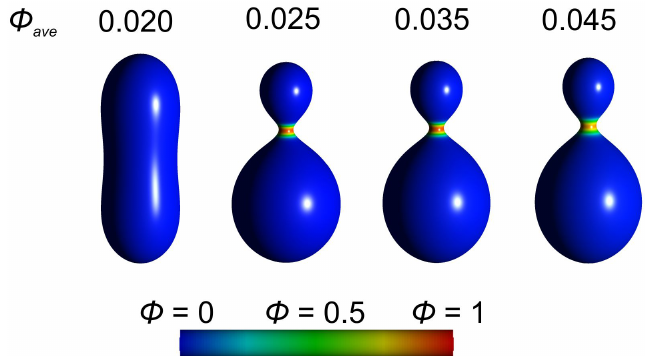
Figure 21. Equilibrium closed membrane shapes calculated for different values of the average relative area density φ ave of anisotropic saddle-like nanodomains A . Membrane contains two types of nanodomains denoted by A (saddle-like anisotropic) and B (isotropic). The average relative area density of nanodomains B is ( 1 − φ ave ) . The red color ( φ = 1) represents the highest possible local relative area density (concentration) of the nanodomains A , while the local concentration of the nanodomains B is given by ( 1 − φ ) . The entropy of mixing was taken into account in minimization of the membrane free energy. Shapes were calculated by minimizing the energy functional given by Equation (49) for the following values of model parameters: v = 0.8 H B m = 2, D B m = 0, H A m = 0, D A m = 8, κ A = 8 κ B , κ B = 30 k B T , R 0 = 250 nm and a 0 = 100 nm 2 . Here, R 0 is the radius of the sphere with the same surface area as the surface of the investigated cell/vesicle. Adapted with permission from ref. [170]. 2020 Public Library of